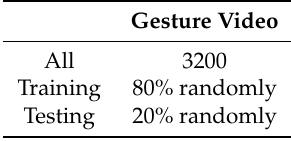
Table 1. Statistical information of LSA